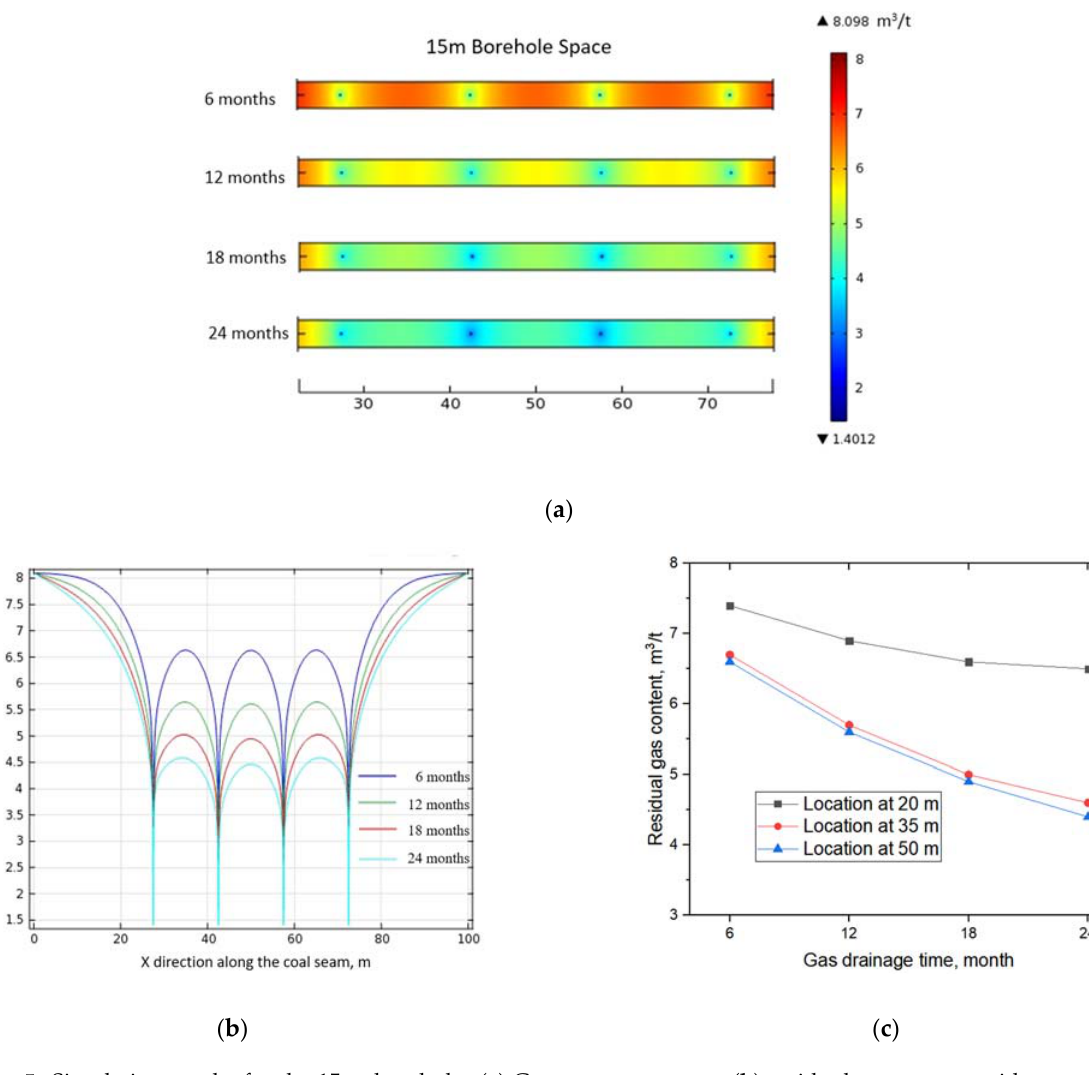
Figure 5. Simulation results for the 15 m borehole. ( a ) Gas content contour; ( b ) residual gas content with respect to X direction along the coal seam; ( c ) gas content at three points with respect to gas drainage time.